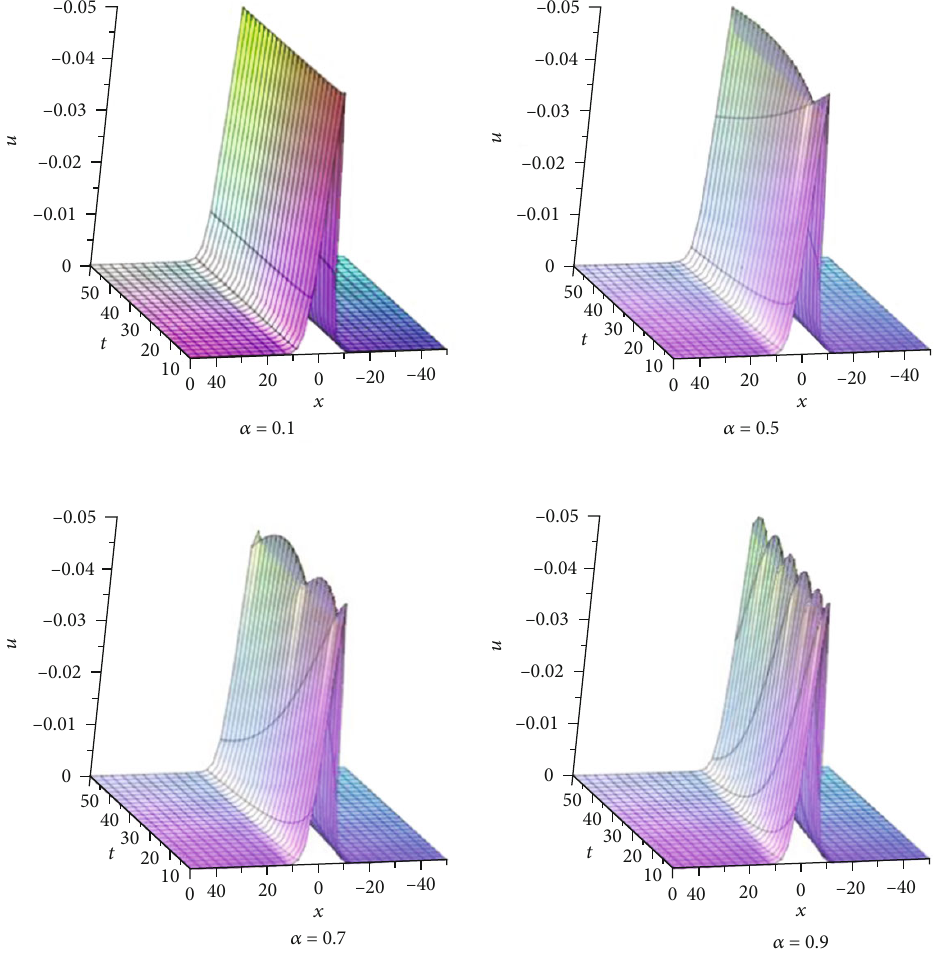
ffiffiffiffiffiffiffiffiffiffiffiffiffiffiffiffi p ffiffiffiffi p λ 2 − 4 μ , λ = 2, μ = 0 : 4